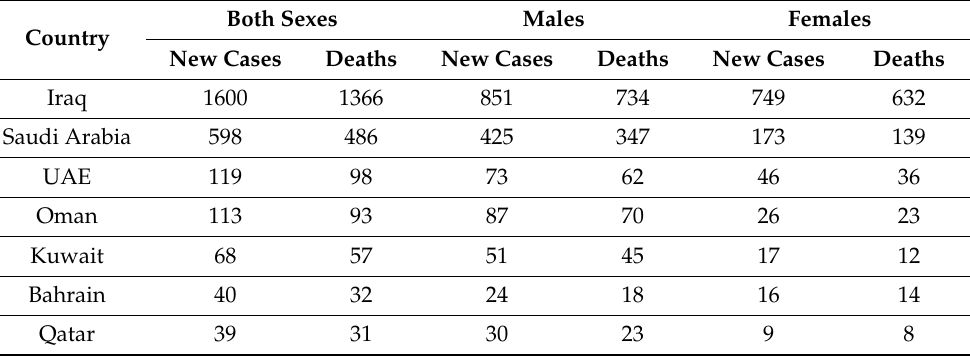
Table 1. Assessed numbers of new cases and deaths in 2020 (per 100,000 individuals) in both sexes among Gulf nations